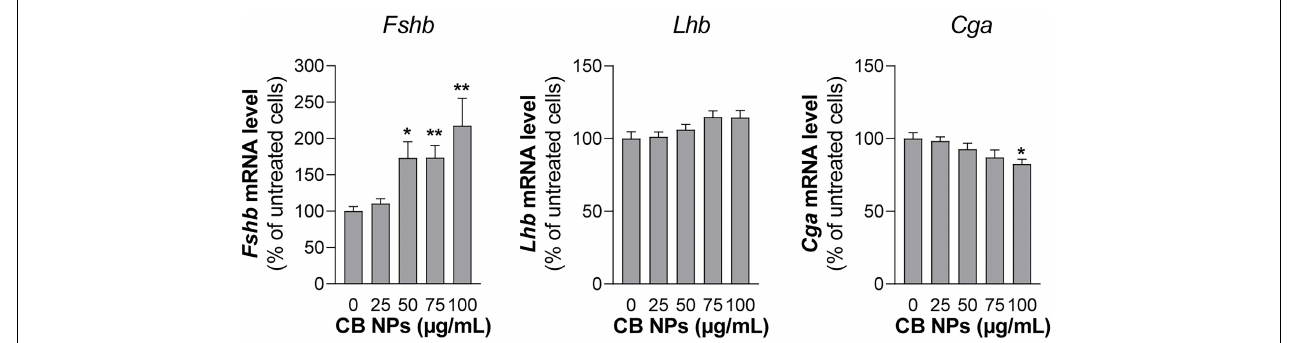
FIGURE 5 | Gonadotropin gene expression in L β T2 gonadotrope cells treated with CB NPs. L β T2 gonadotrope cells were cultured for 24 h with increasing concentrations of CB NPs (25–100 µ g/mL). At the end of the incubation, cells were extensively washed, total RNA were extracted and Fshb , Lhb and Cga mRNA levels were determined by real-time quantitative PCR. Data are expressed as percentage over untreated cells and expressed as means ± SEM from 5 to 8 independent experiments. Statistical differences were determined by non-parametric Kruskal-Wallis test followed by Dunnet’s multiple comparison test. * p < 0.05 and ** p < 0.01 compared to no CB NPs.